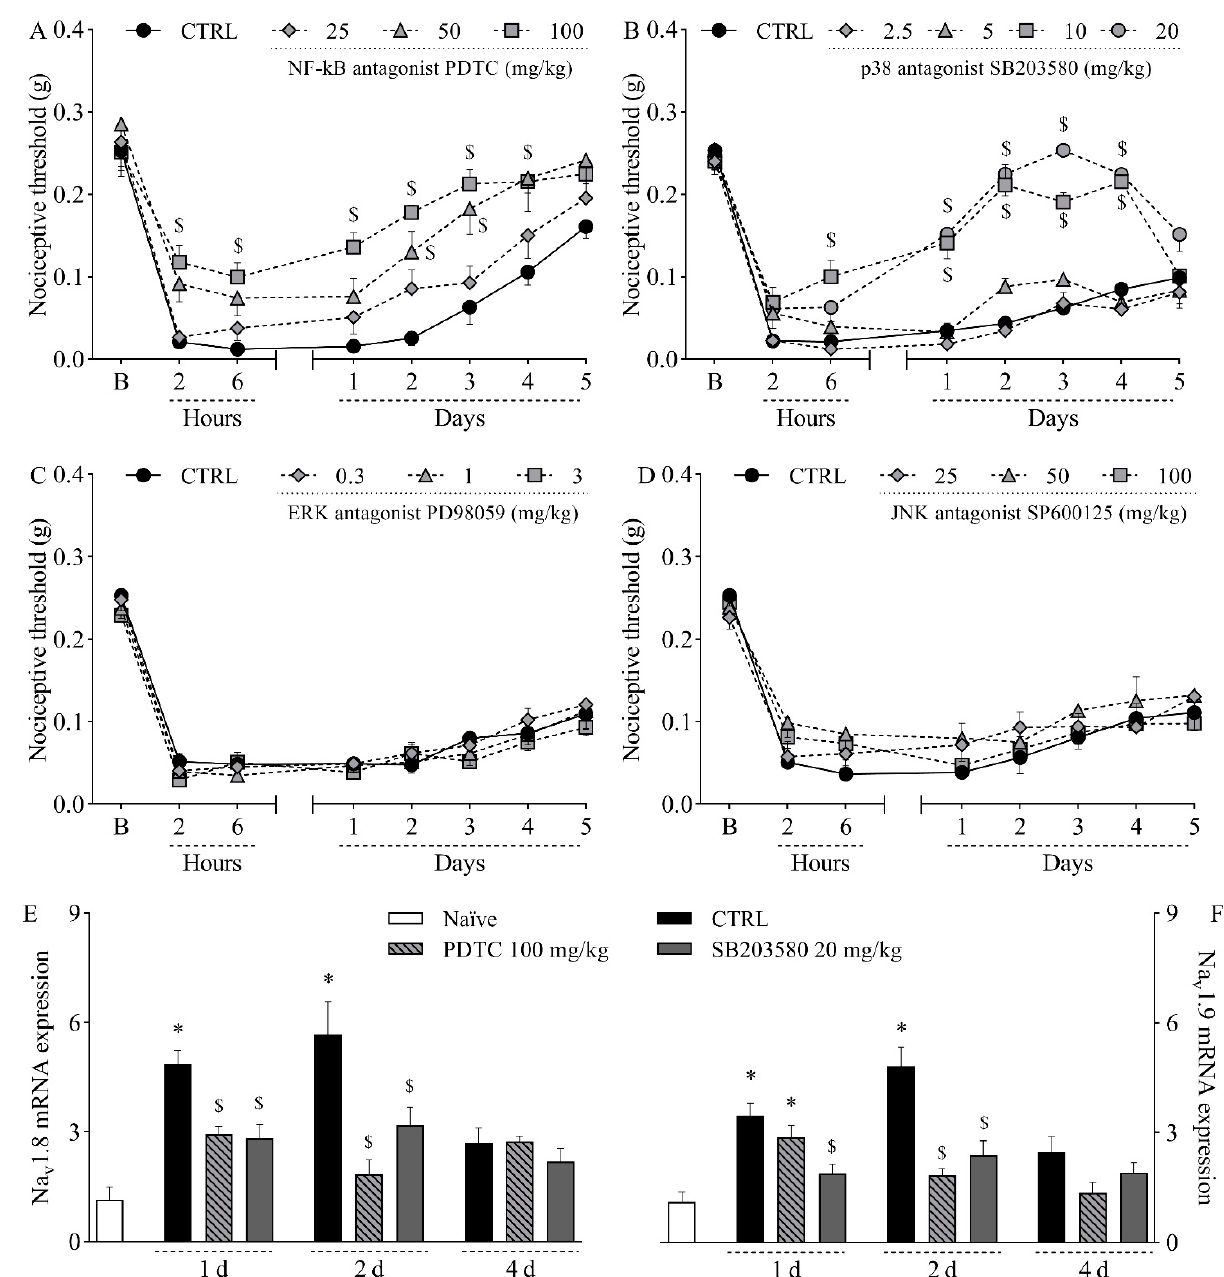
Figure 5. Influence of different MAPK and NF- κ B antagonists on the mechanical hypernociception and on the upregulation of Na v 1.8 and Na v 1.9 in the dorsal root ganglia following plantar incision. Mice were treated with the NF-kB antagonist PDTC (25–100 mg/kg, intraperitoneally), the p38 antagonist SB203580 (2.5–20 mg/kg, intraperitoneally), the ERK antagonist PD98059 (0.3–3 mg/kg, subcutaneously), the JNK antagonist SP600125 (25–100 mg/kg, subcutaneously), or the vehicle (CTRL; control group) one hour before the induction of the plantar incision model of postoperative pain. No surgical procedures nor treatments were performed on the naïve mice. ( A – D ) The mechanical nociceptive threshold (axis of ordinates) was evaluated at baseline ( B ) and at different times in hours and days after plantar incision (axis of abscissas). Values represent the filament weight (g) to which mice respond in 50% of presentations. Data are expressed as means ± SD ( n = 6). $ p < 0.05 compared with CTRL group. Two-way ANOVA followed by Bonferroni’s test. ( E , F ) The levels of Na v 1.8 mRNA ( E ) and Na v 1.9 mRNA ( F ) in the DRG (axis of ordinates) were determined by Real-Time PCR